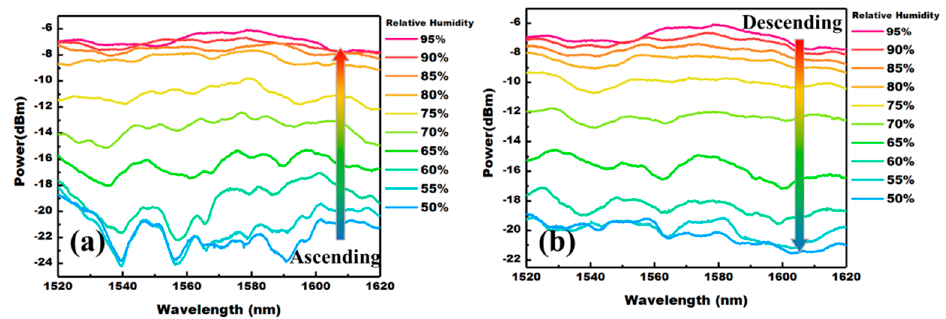
Figure 8. The variation of the transmitted spectrum in RH ascending ( a ) and descending ( b ) pro- cesses.